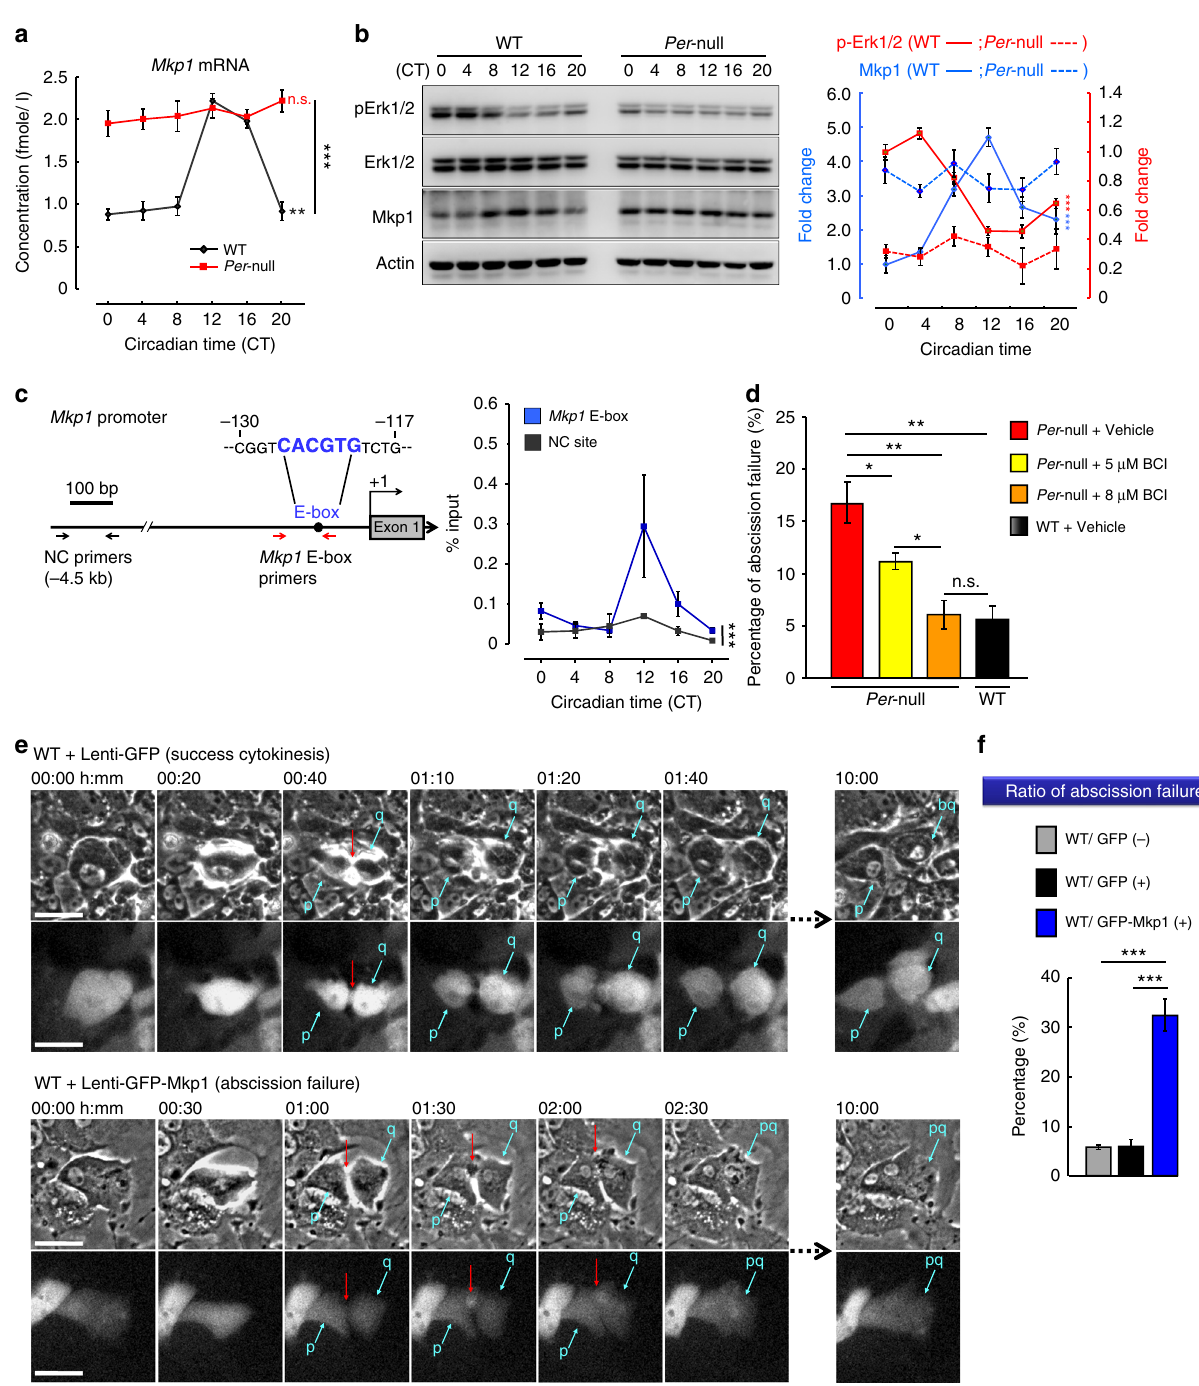
Fig. 5 Upregulation of Mkp1 in Per -null liver promotes abscission failure. a Rhythmic expression of Mkp1 in WT liver but constitutively high in Per -null (WT, n = 5; Per -null, n = 3). b Immunoblotting and its quantitative analysis showing antiphasic expression of pErk1/2 and Mkp1 in WT and Per- null livers. (WT, n = 5; Per -null, n = 3). c Chromatin immunoprecipitation (ChIP)-assay of circadian Per1 binding on Mkp1 promoter E-box. ChIP regions are schematically shown on Mkp1 promoter. NC, negative control. d Mkp1 inhibitor (BCI) dose-dependently decreases the ratio of abscission failure in cultured Per -null hepatocytes (vehicle, n = 283; 5 μ M BCI, n = 275; 8 μ M BCI, n = 304) to normal levels (WT, n = 323). e , f Overexpression of Mkp1 increases the ratio of abscission failure in cultured hepatocytes. Representative images of cells infected with lentivirus carrying either Mkp1-GFP (Lenti-Mkp1-GFP) or GFP (Lenti-GFP) ( e and Supplementary Movie 3), and quanti fi cation of abscission failure in indicated group ( f ). Red arrows indicate the intercellular bridge between two daughter cells (p and q) (WT/GFP-, n = 257, WT/GFP + , n = 209, WT/GFP-Mkp1+ , n = 189; 3 experiments for each group). Data are representative of at least three independent experiments. Two-way ANOVA ( a – c ) and One-way ANOVA ( d , f ) with Bonferroni ’ s post-test were applied. All values represent the mean ± SEM. * P < 0.05, ** P < 0.01, *** P < 0.001. Scale bar, 50 μ